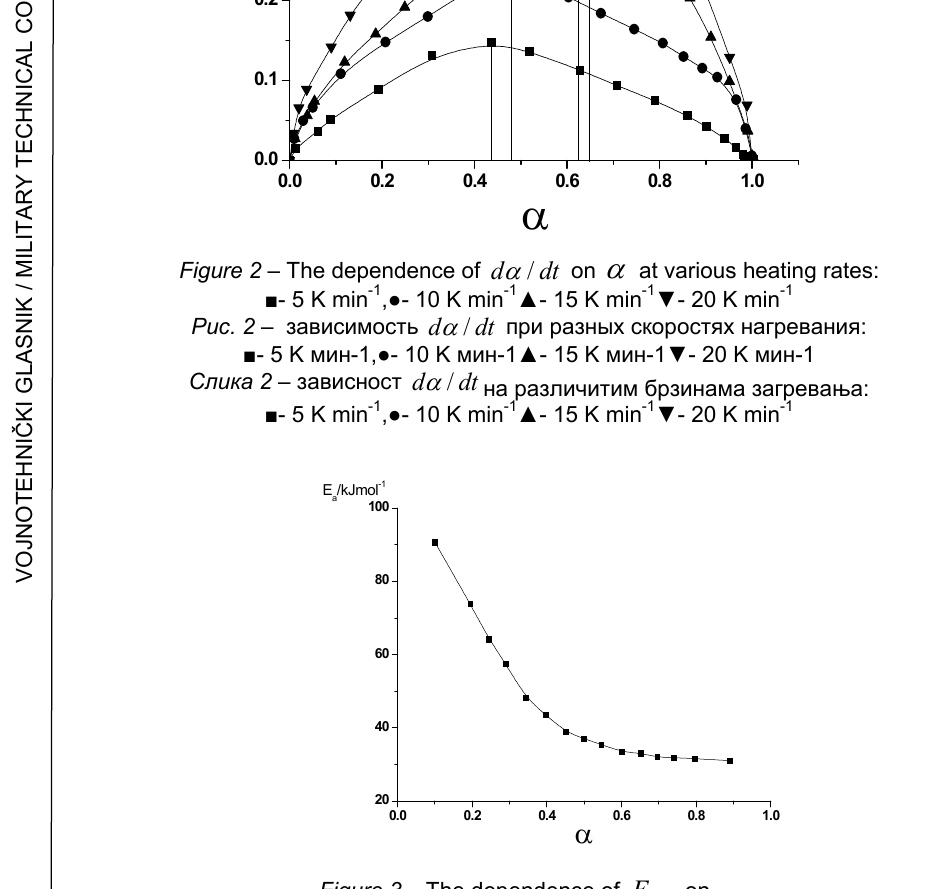
E on  , a  E o т  , a  E od , a 